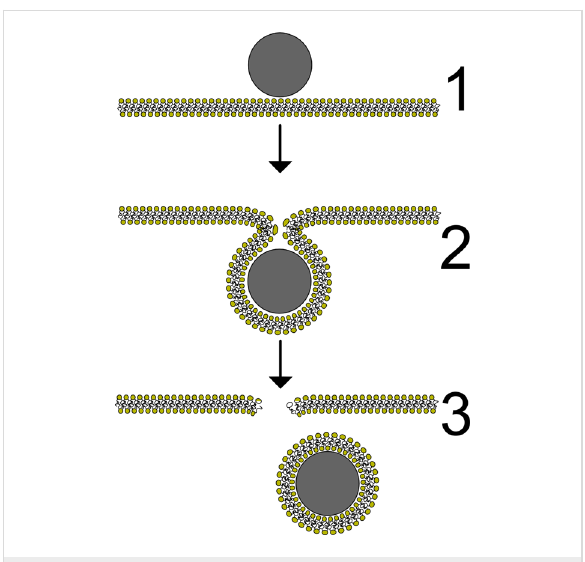
Figure 1: An endocytosis-like uptake of particles involves three major steps: adhesion (1), engulfment (2), and fission (3). During the last process a membrane defect is induced, which will heal over